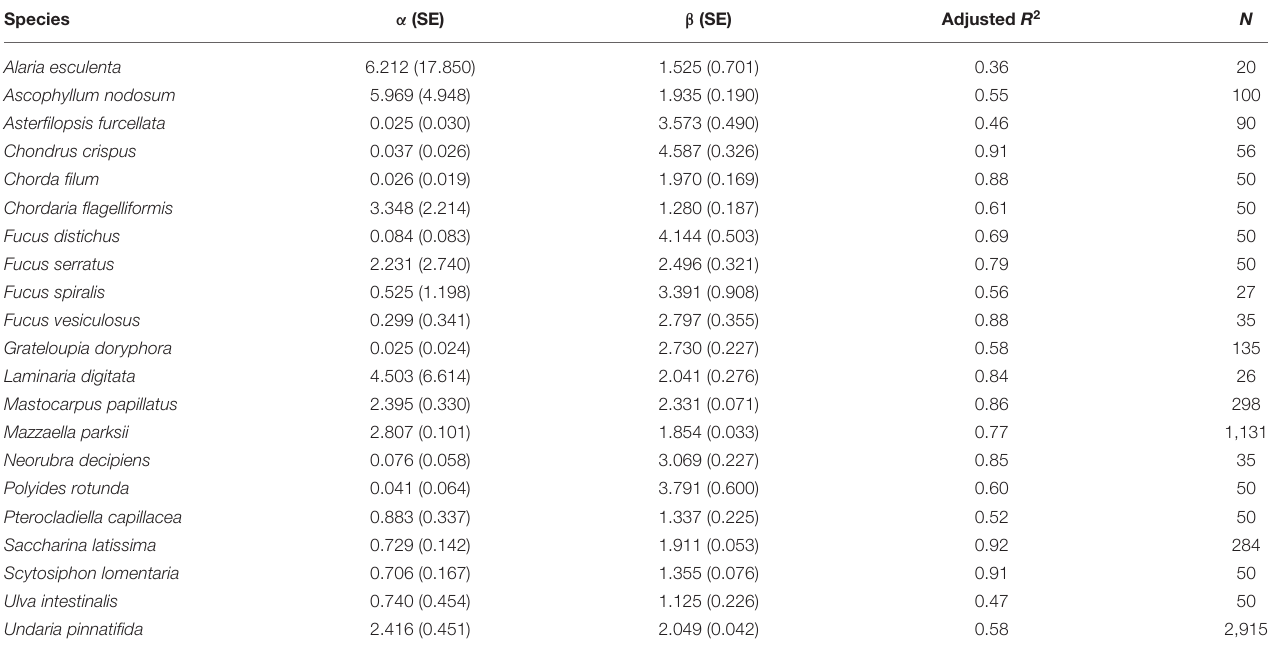
TABLE 1 | Model parameters (with standard error, SE, in parentheses) for the power relationship between length ( L , in cm) and dry biomass ( B , in mg), B = α L β , for the studied seaweeds, including the adjusted R 2 and sample size for each case.